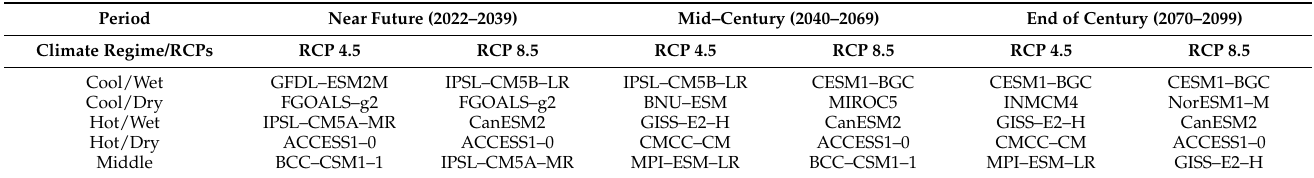
Table 1. Models selected for Regional Integrated Assessment for climate change